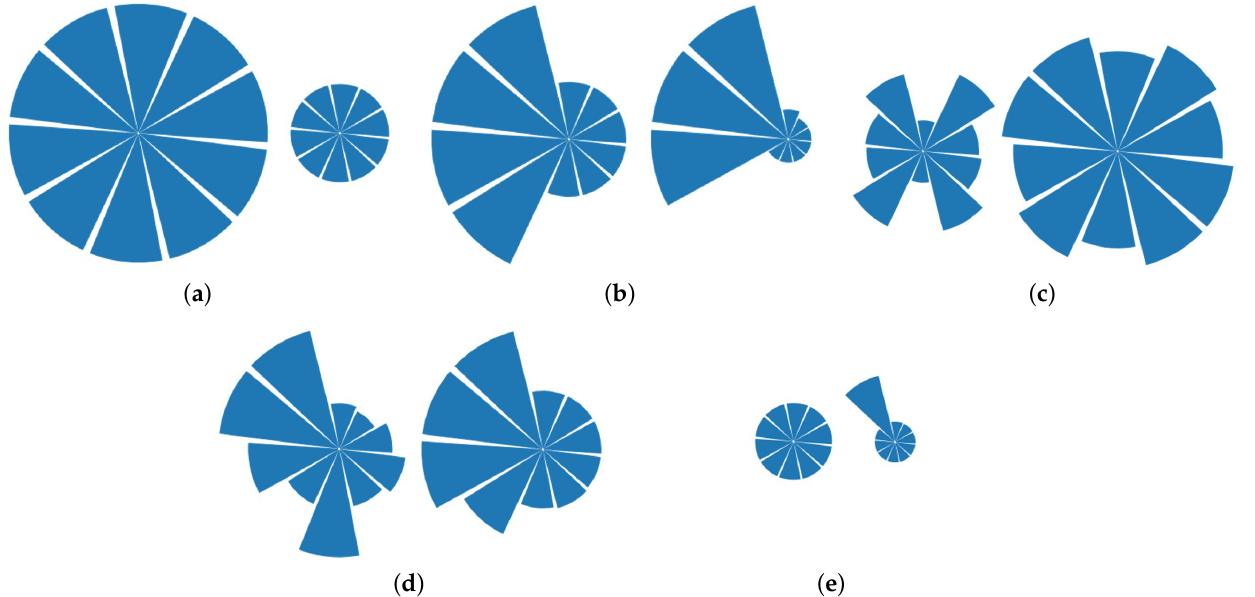
Figure 4. Characteristics of the temporal bar graph patterns with a single load. ( a ) DW, ( b ) Kettle, ( c ) WM, ( d ) MW, and ( e ) Fridge.